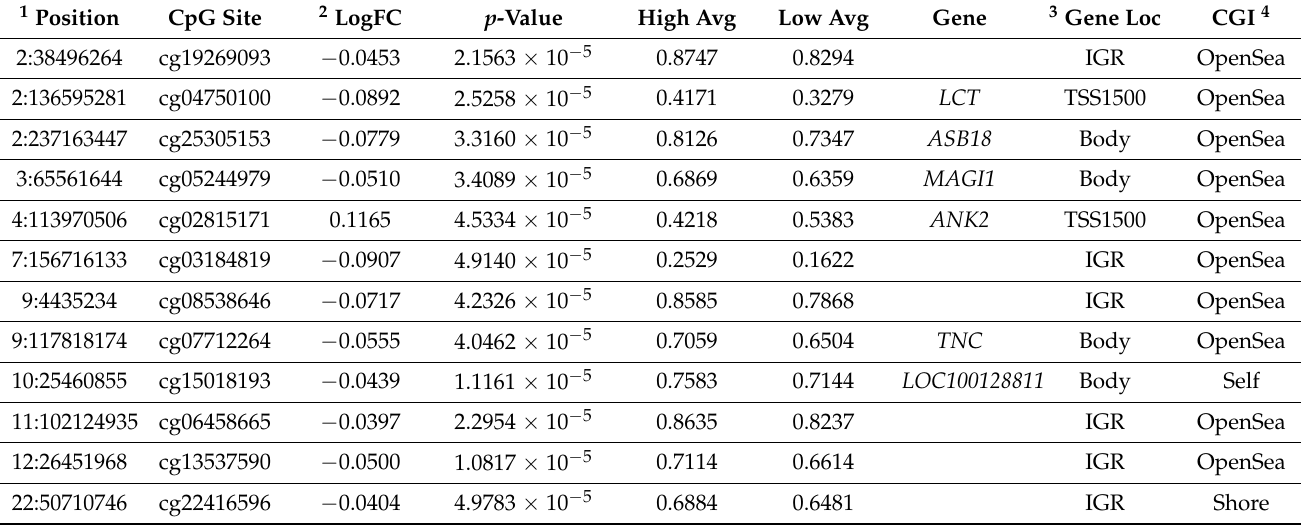
Table 2. Epigenome-wide nominal associations between high and low duration of